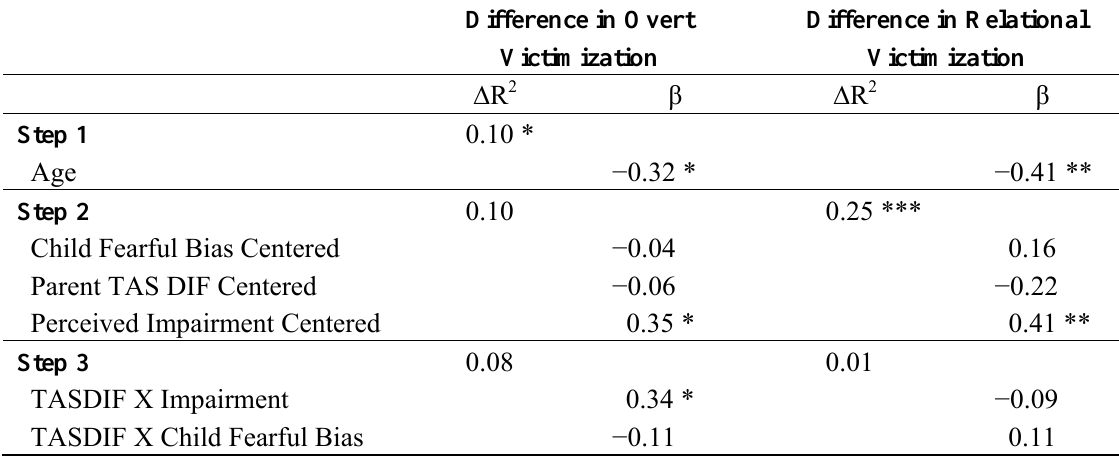
Table 3. Hierarchical Multiple Regression Analyses Predicting Differences in Reports of Victimization (Child Minus Parent